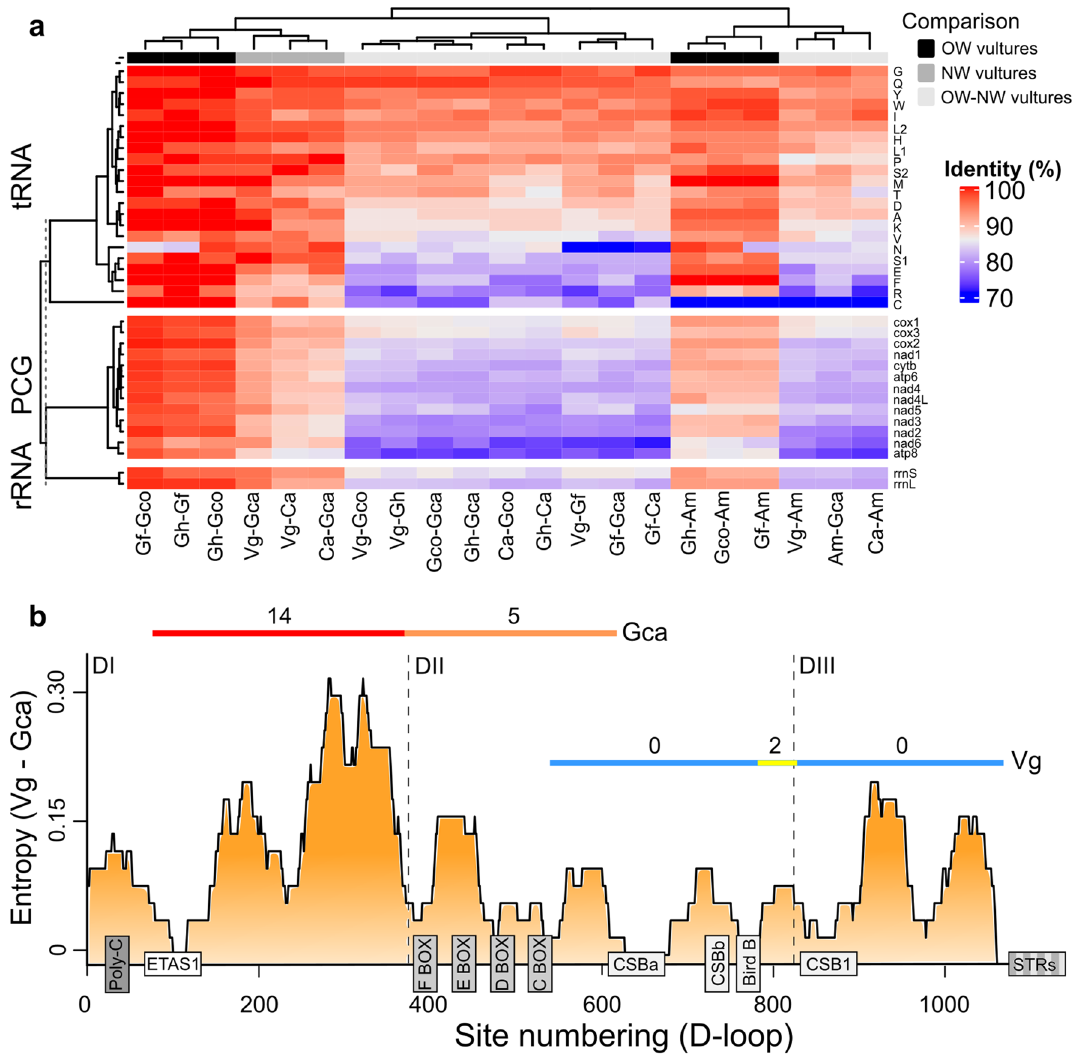
D-loop region, based on a 50-bp sliding window (interspecific variation). The organization of conserved elements and domain limits are denoted. Cold and warm colored bars indicate invariant to highly variable regions reported for both species of condors (intraspecific variation: the number of polymorphic sites is indicated at the top). Vg: V. gryphus ; Gca: G. californianus ; Ca: C. aura ; Gh: G. himalayensis ; Gf: G. fulvus ; Gco: G. coprotheres ; Am: A. monachus . Heatmap and entropy charts were plotted with R 4.0.2 (https:// www.r- proje ct.